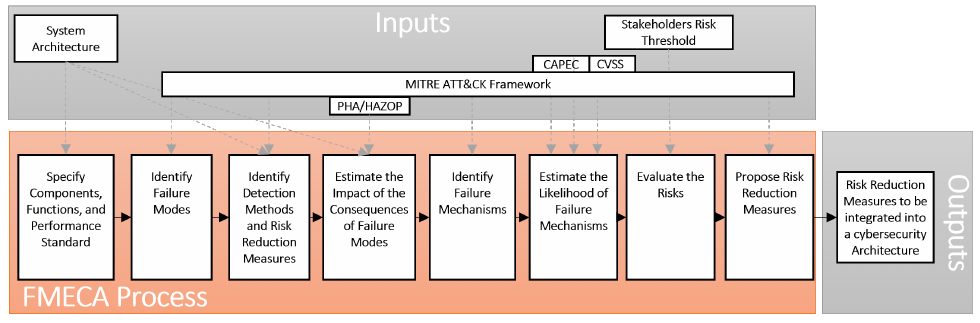
Figure 1. Steps of FMECA-ATT&CK with the knowledge sources (adapted from